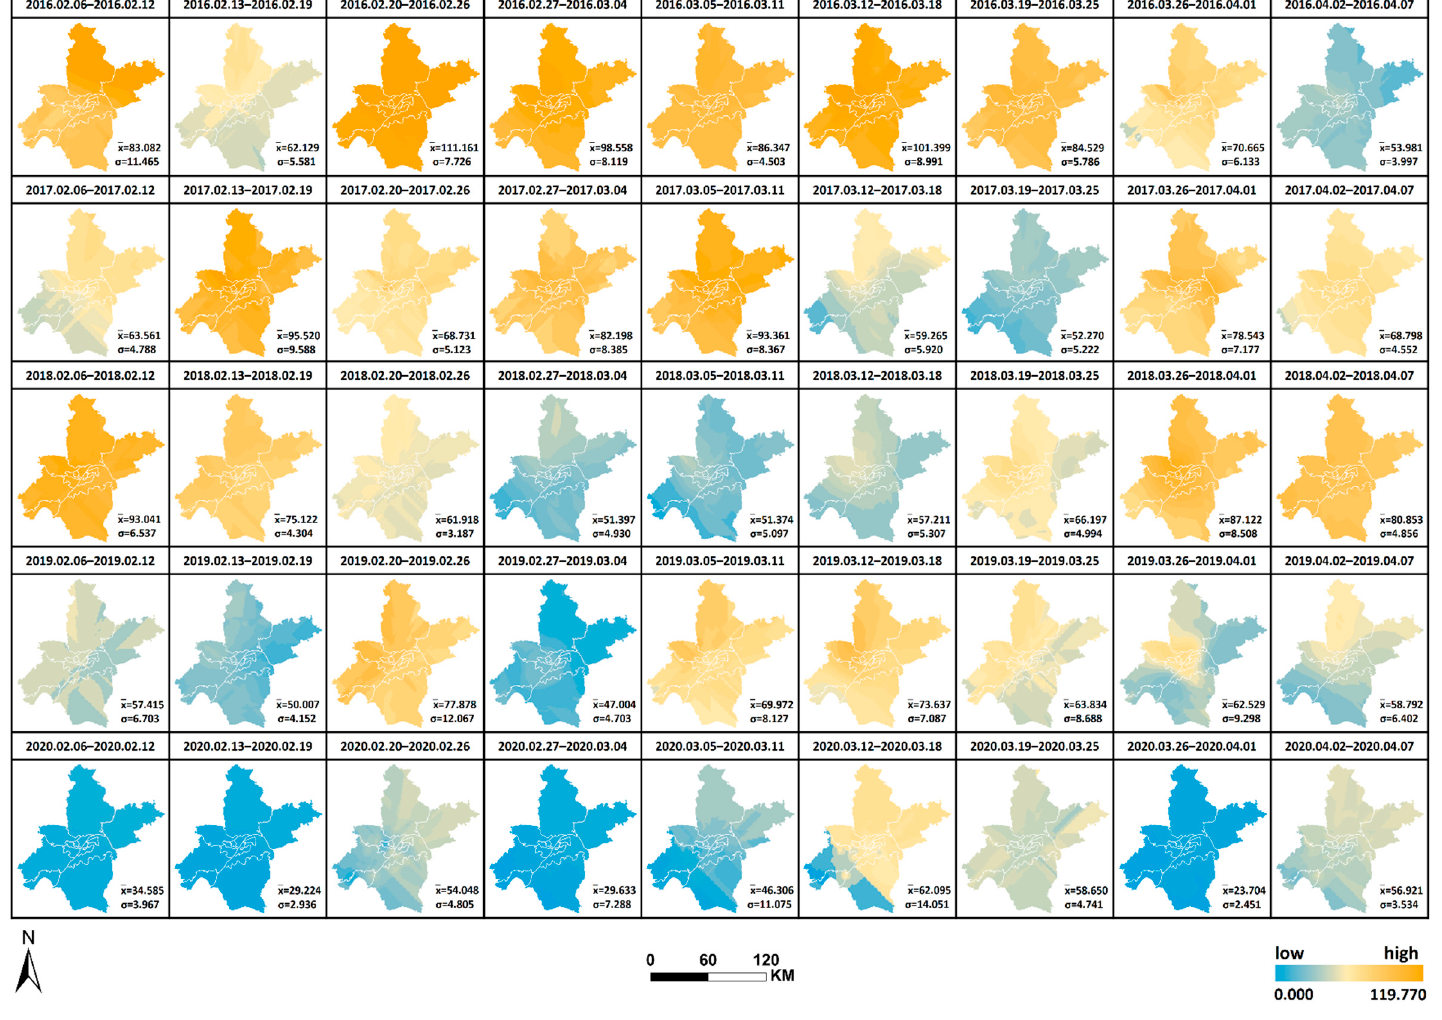
Figure 10. PM 10 interpolation chart from 2016 to 2020.